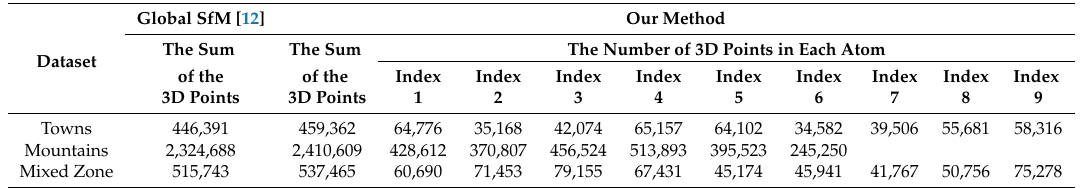
Table 4. The statistics of the reconstructed 3D points of our method and the global SfM.